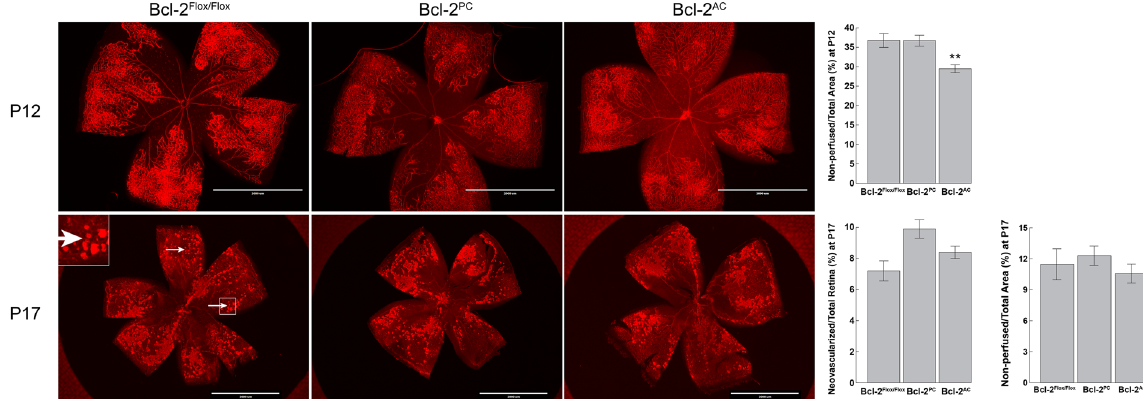
Figure 7. Hyperoxia-driven retinal neovascularization is not impacted by conditional lack of Bcl-2 expression. Mice were exposed to a cycle of hyperoxia and room air (OIR). To visualize the vasculature, retinas from P12 and P17 Bcl-2 Flox/Flox and conditional Bcl-2 littermates were wholemount stained with anti-collagen IV. At P12 and P17 the area of vessel obliteration relative to the whole retina was quantified (n = 6, ** P < 0.01). In the lower panel at P17 the area of neovascularization relative to the area of the retina was quantified (n = 6, P > 0.05). Arrows point to neovascular tufts, in which an area of interest in noted and magnified 300% in the inset. Please note similar levels of neovascularization in Bcl-2 Flox/Flox mice their littermates conditionally lacking Bcl-2. Scale bar = 2000 µ m.